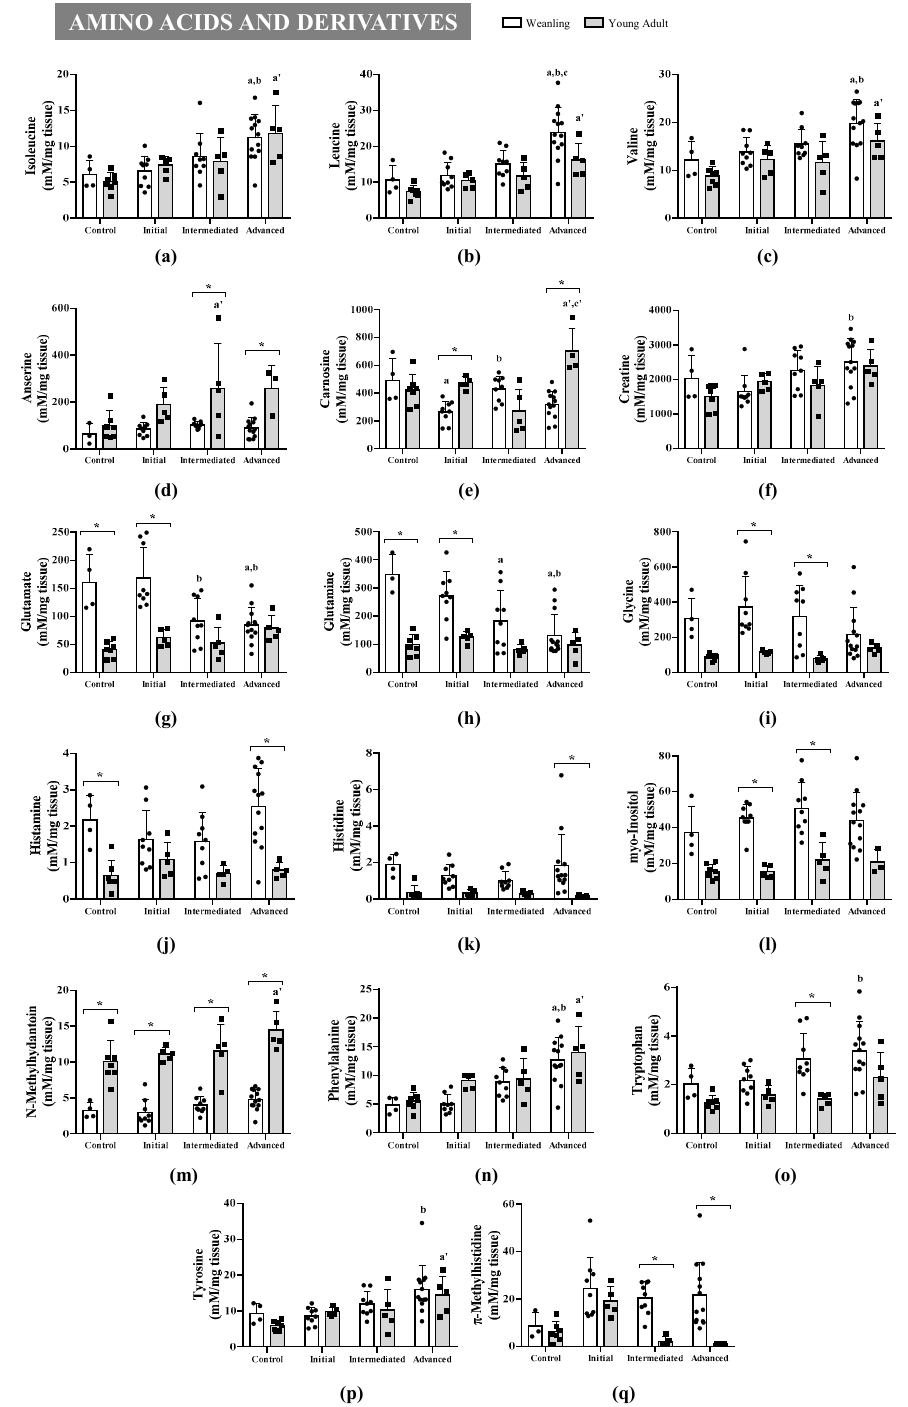
Figure 2. Gastrocnemius muscles’ metabolic profile of amino acids and derivatives identified in weanling and young adult female Walker-256 tumour-bearing rats. Concentration of BCAAs: ( a ) isoleucine, ( b ) leucine, ( c ) valine, ( d ) anserine, ( e ) carnosine, ( f ) creatine, ( g ) glutamate, ( h ) glutamine, ( i ) glycine, ( j ) histamine, ( k ) histidine, ( l ) myo-inositol, ( m ) N-methyl-hydantoin, ( n ) phenylalanine, ( o ) tryptophan, ( p ) tyrosine, and ( q ) π -methylhistidine metabolites distributed into weanling and young adult control (WC and AC) and initial (WWi and AWi), intermediate (WWm and AWm) and advanced (WWa and Awa) Walker tumour-bearing animals. Legend: Data are expressed as means ± standard deviation and analysed by two-way ANOVA, followed by post-hoc Tukey’s honestly significant difference. p -value < 0.05 in comparison with (a) WC, (b) WWi, and (c) WWm groups; with (a’) AC, (b’) AWi, and (c’) AWm groups; and with young adult (*) groups.